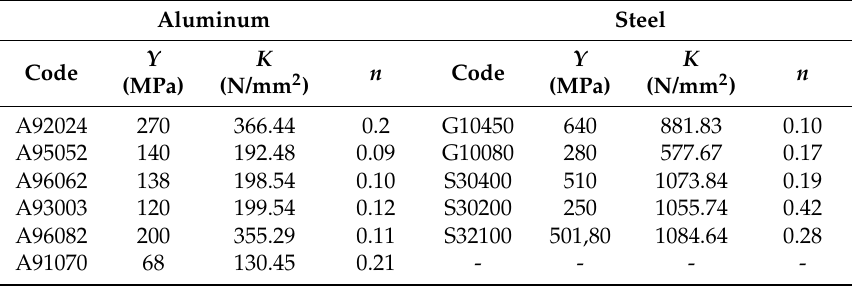
Table 1. Aluminum and steel alloys characteristics. Unified Numbering System codification